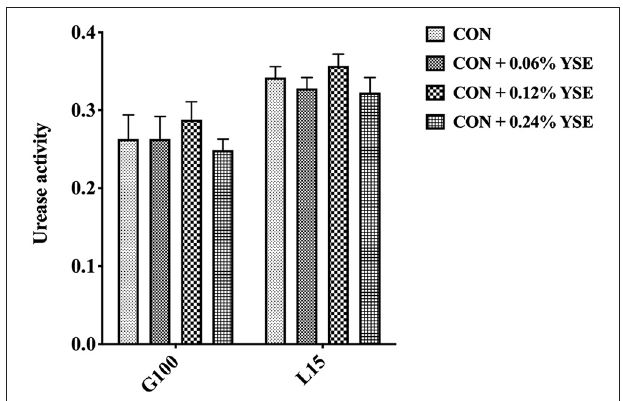
FIGURE 4 | The effect of YSE supplementation on urease activity in sow manure during gestation and lactation.